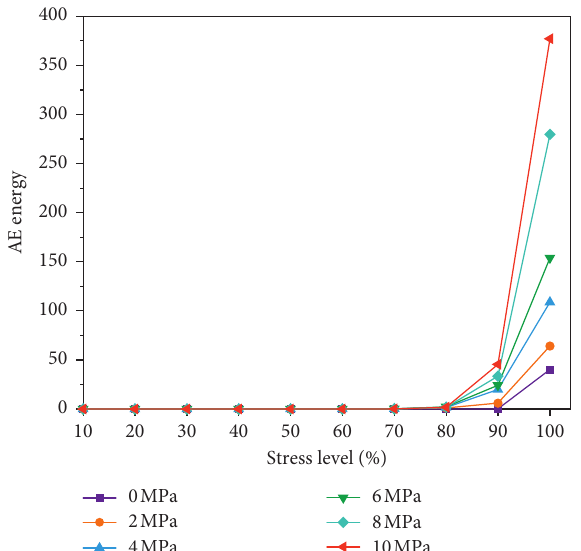
Figure 16: Relationship between stress levels and AE Energy under different confining pressures.